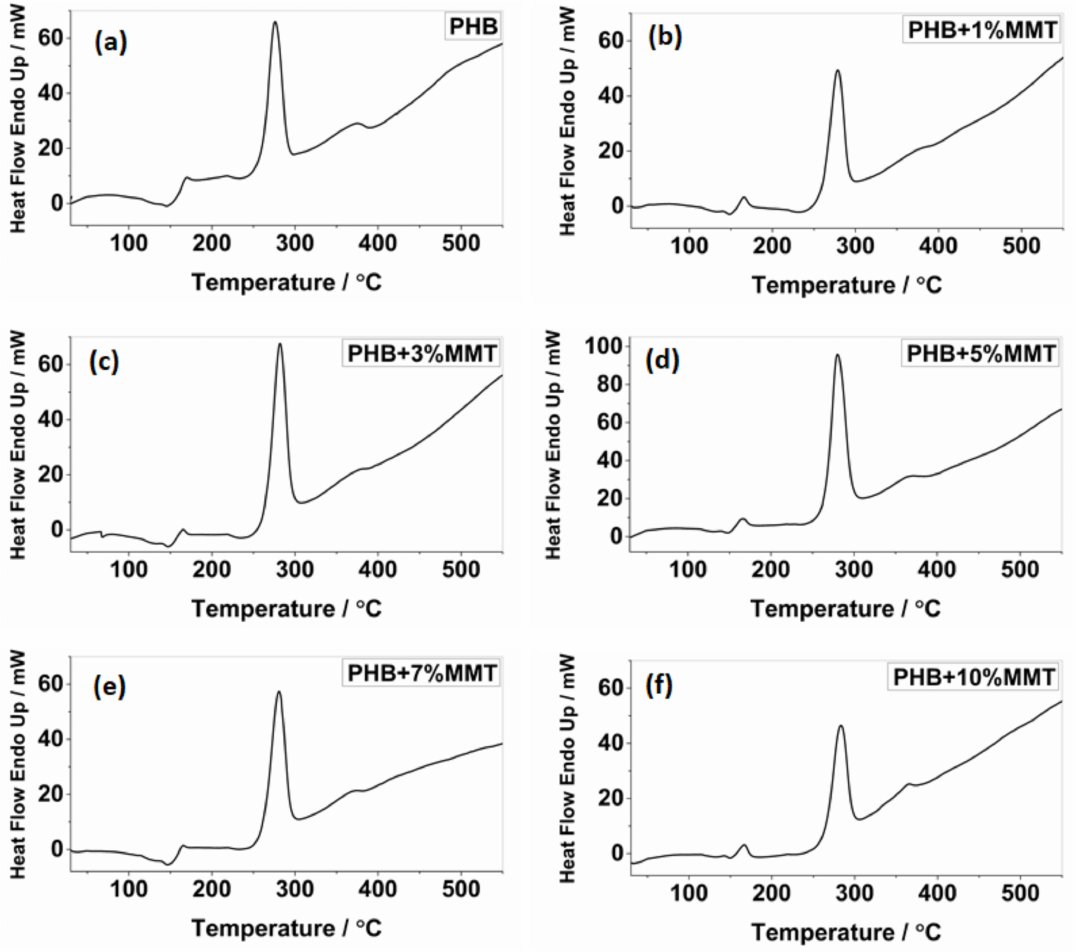
Figure 3. DSC thermograph showing endotherms for ( a ) pure PHB, ( b ) PHB + 1 wt% OMMT, ( c ) PHB + 3 wt% OMMT, ( d ) PHB + 5 wt% OMMT, ( e ) PHB + 7 wt% OMMT, and ( f ) PHB + 10 wt%